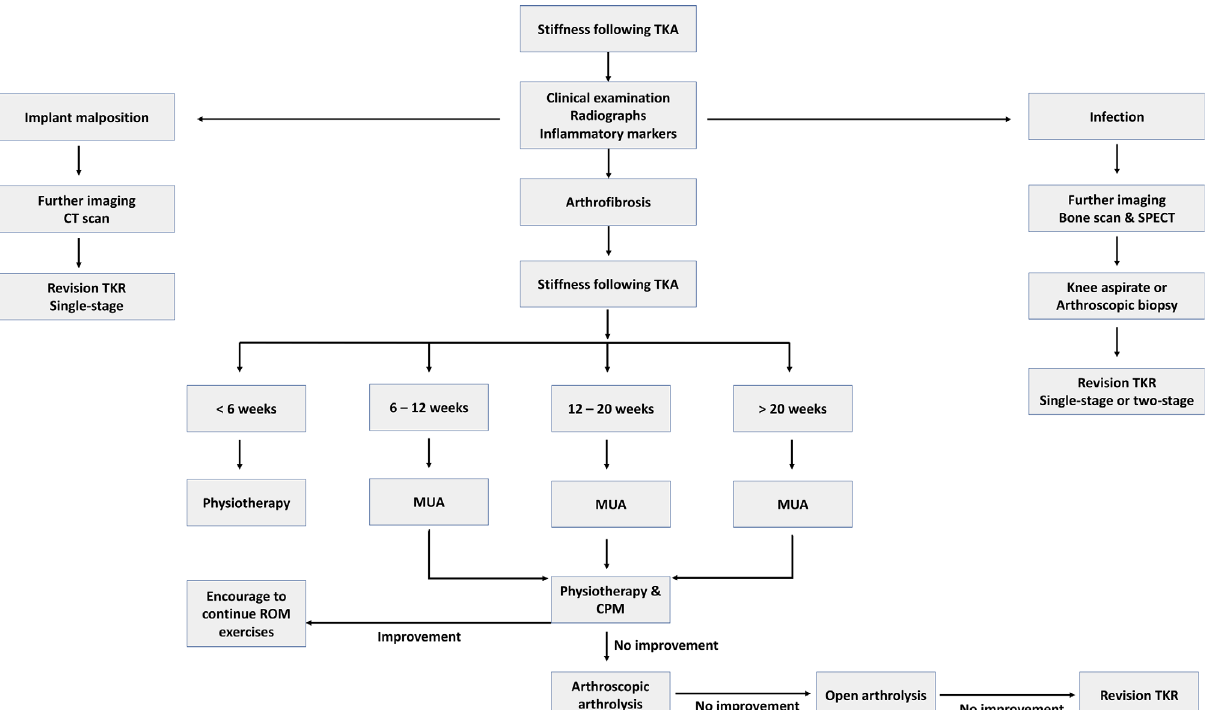
Figure 6. Algorithm for the treatment of stiffness post total knee